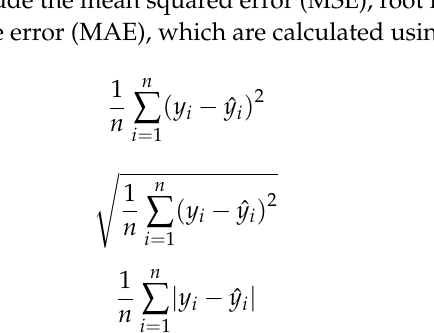
Figure 8. Comparison of the measured and predicted values for the indoor load.